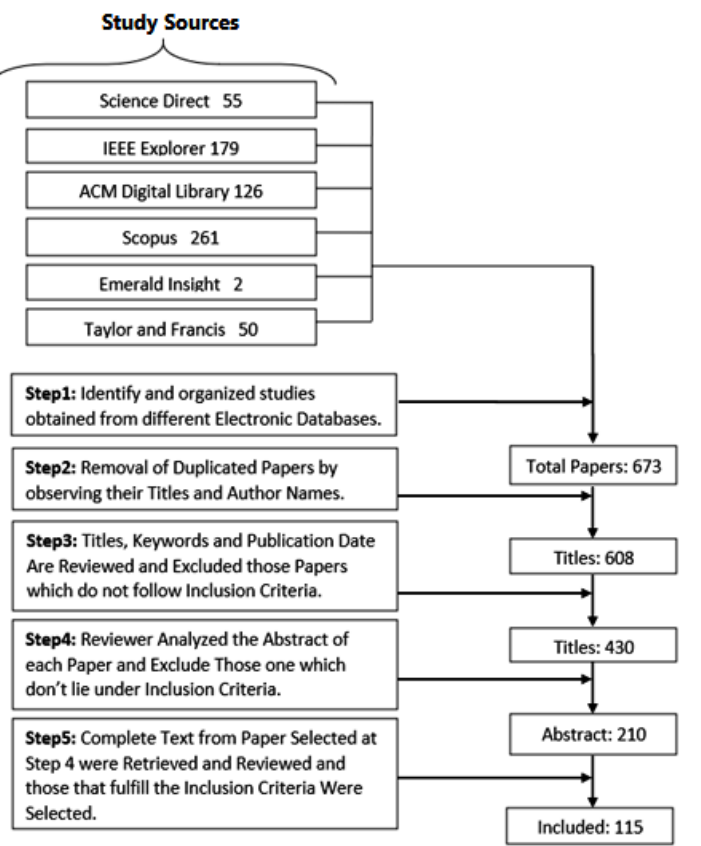
Figure 2. Flowchart representing the process of paper search and selection.